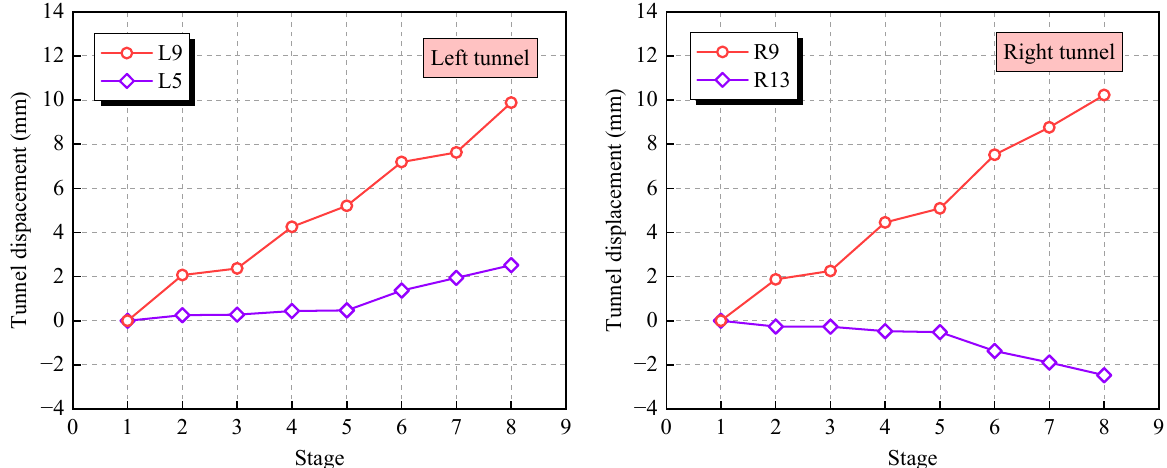
Figure 7. Tunnel displacement with construction simulation stage.